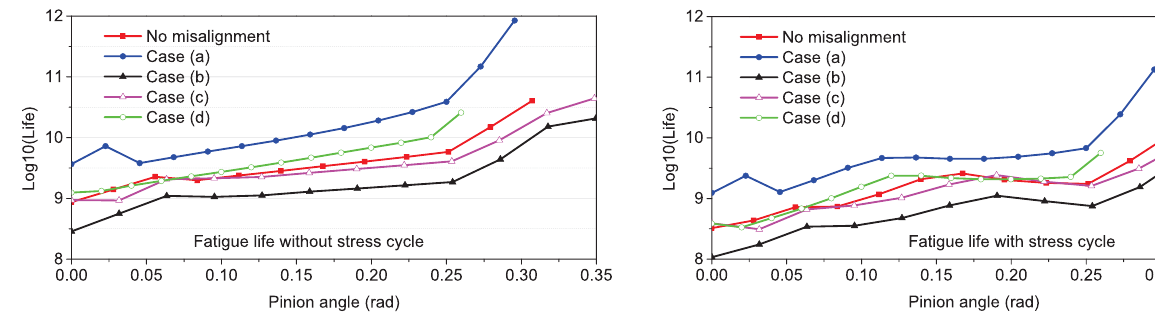
Fig. 16 Fatigue life under different cases of assembling misalign- ments (without asperity stress cycle counting).